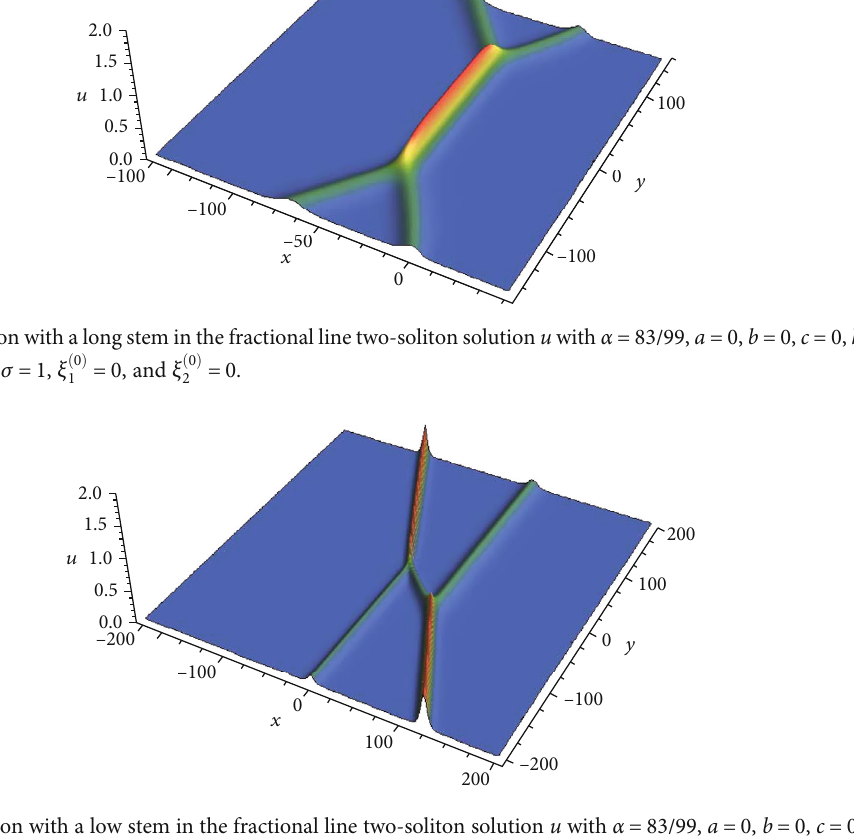
0 Þ = 0 , and ξ ð 0 Þ = 0 . 1 2